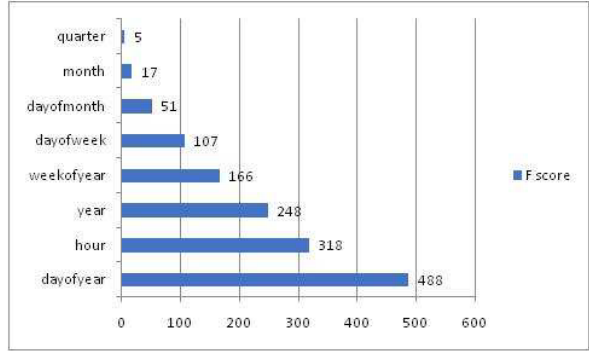
Figure 3: Gradient boosting: feature importance.